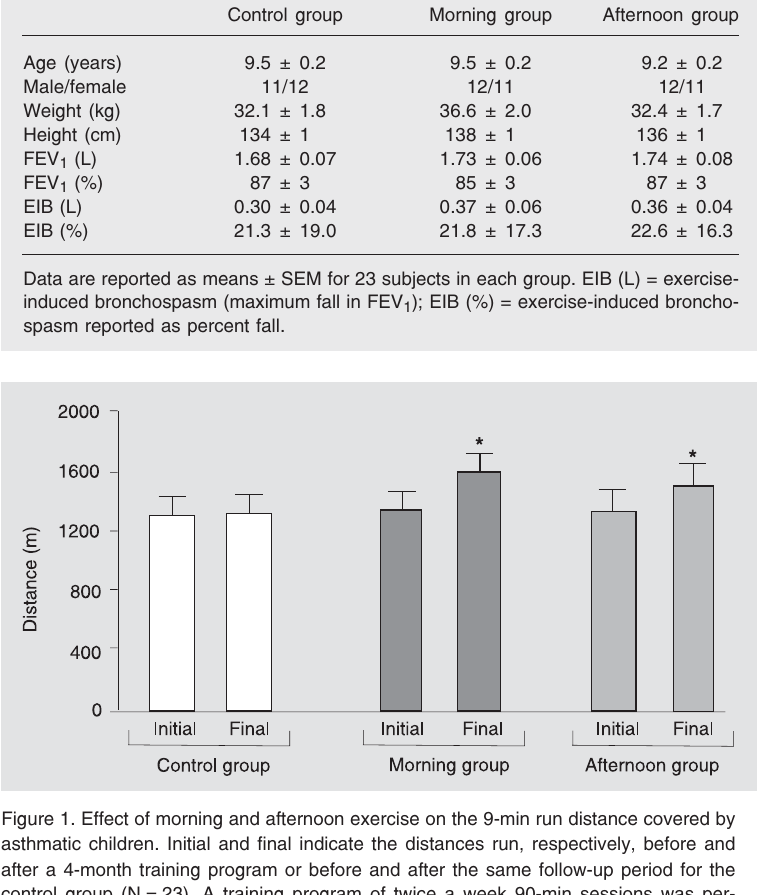
Table 1. Anthropometric and pulmonary function data of the asthmatic patients studied.